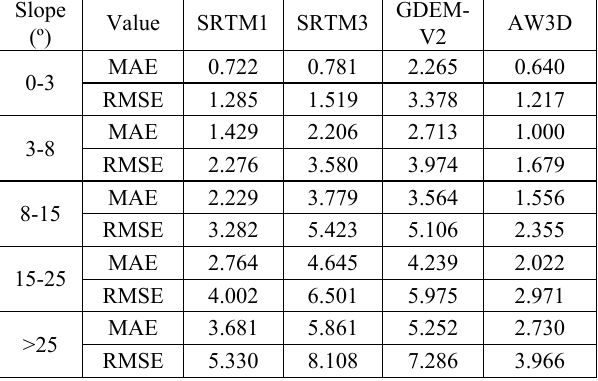
Table 2. Relative Error of typical DEM datasets based on different slope classes (m)